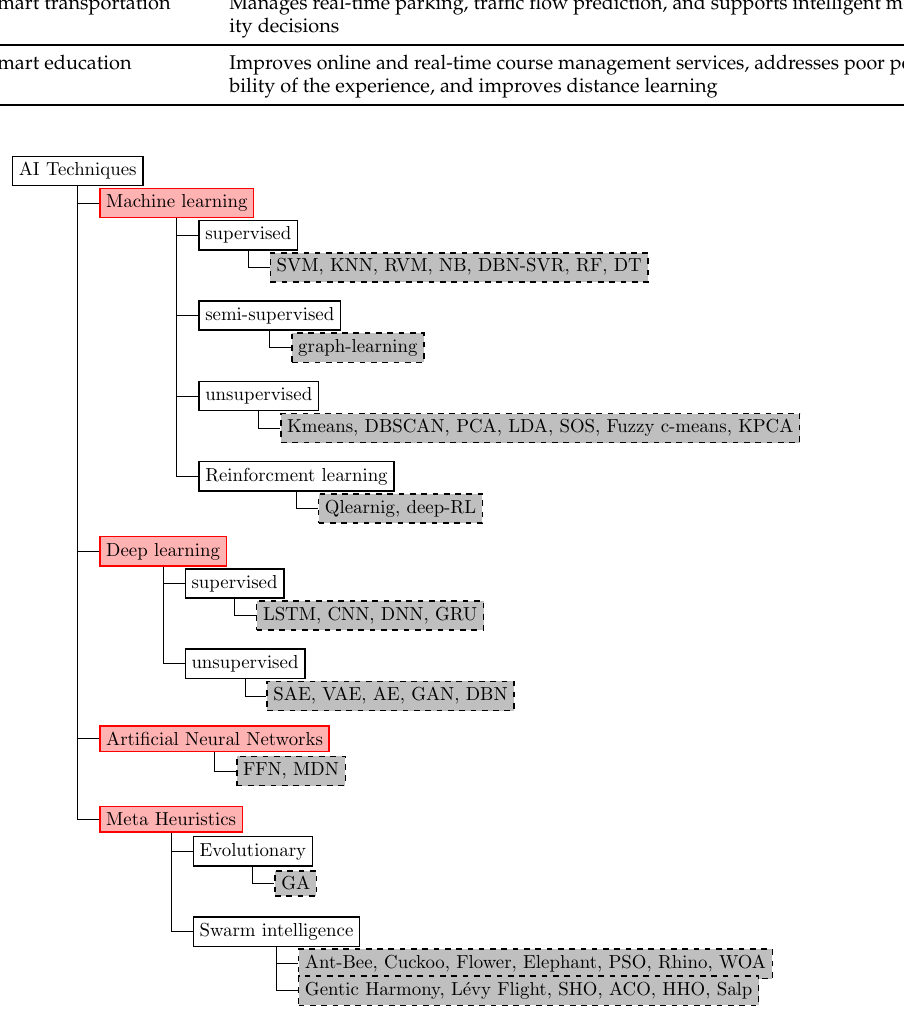
Figure 3. Categorization of AI